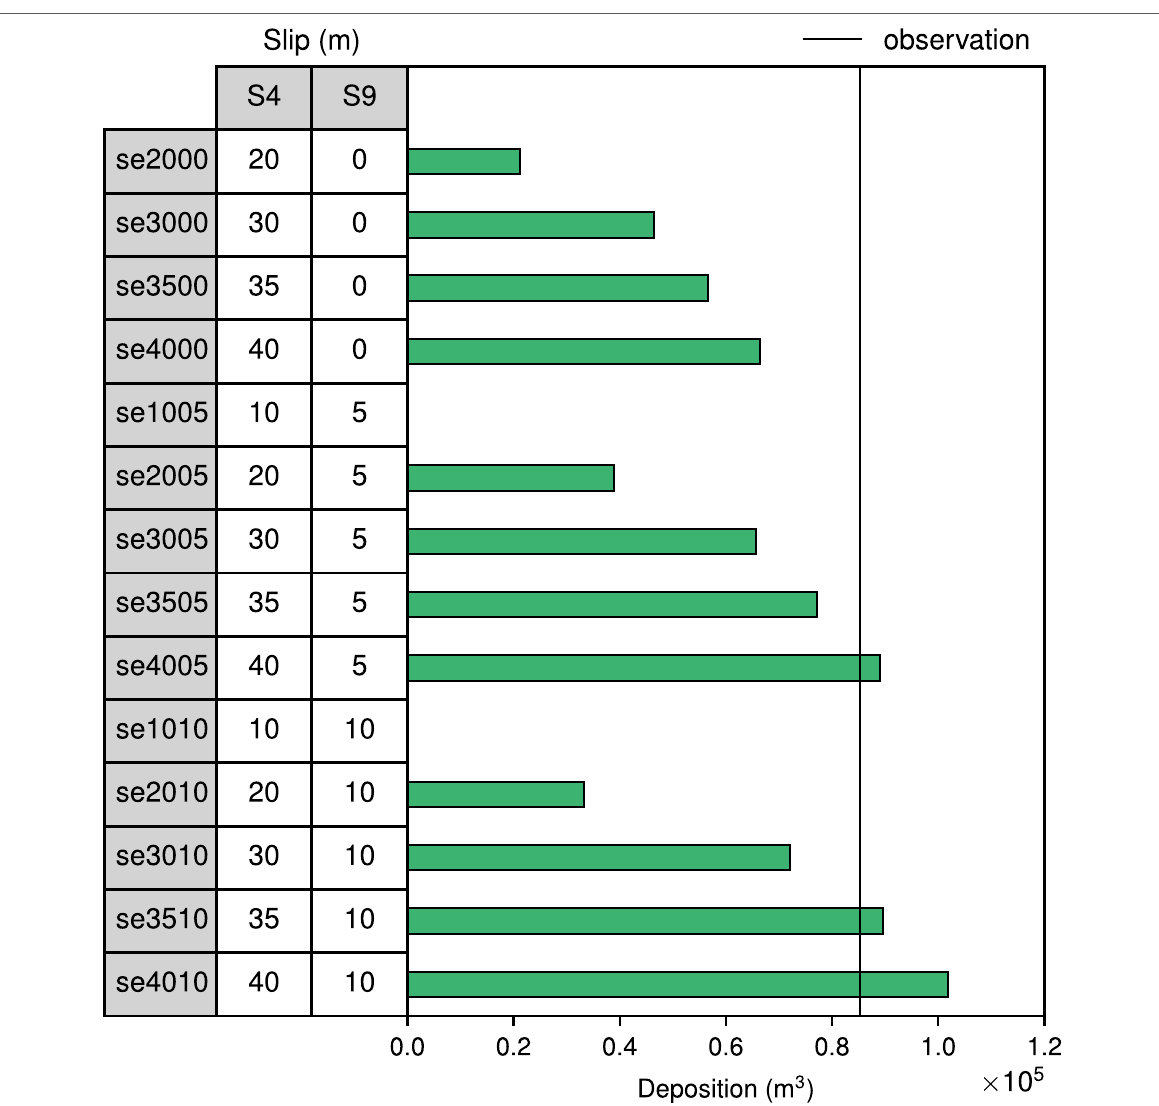
Fig. 5 Calculated deposition volumes from 14 models with varying fault slips on subfaults S4 and S9. Hypothetical models se3510 and se4005 well reproduced the depositional volume estimated based on the observation; black line (Abe et al.